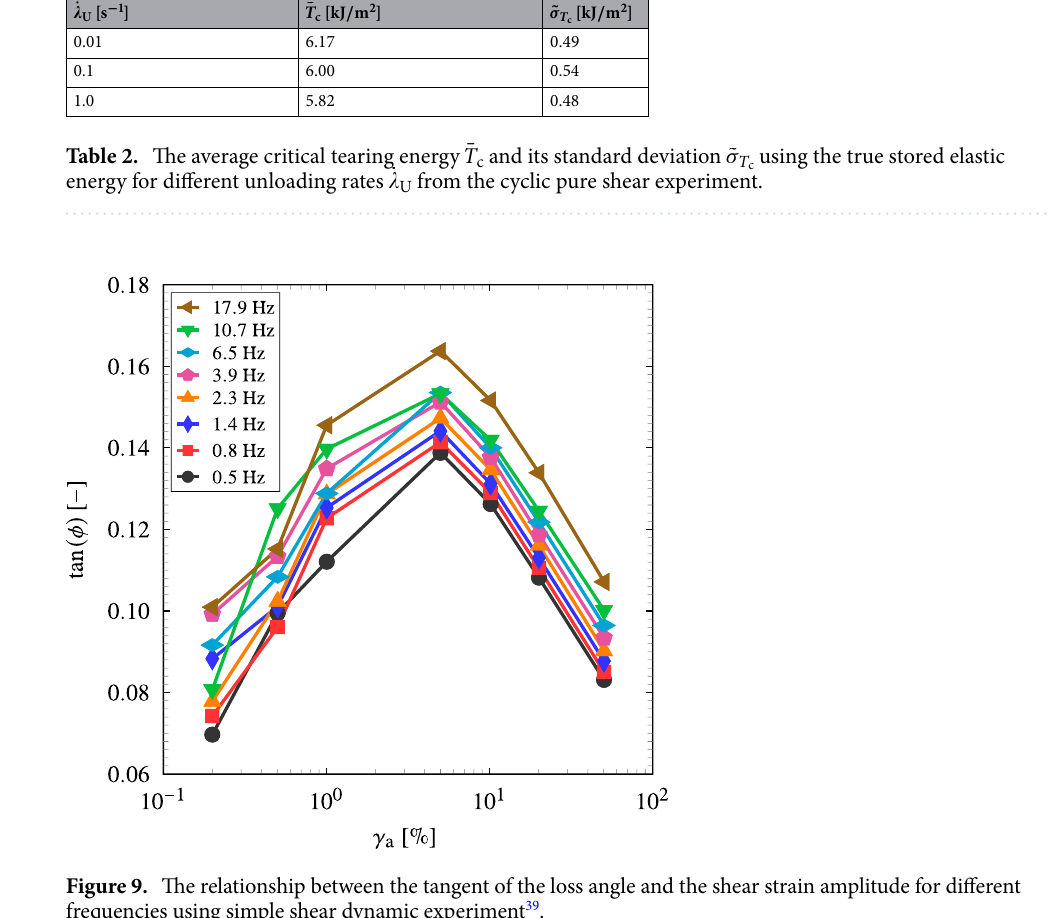
Figure 9. The relationship between the tangent of the loss angle and the shear strain amplitude for different frequencies using simple shear dynamic experiment 39